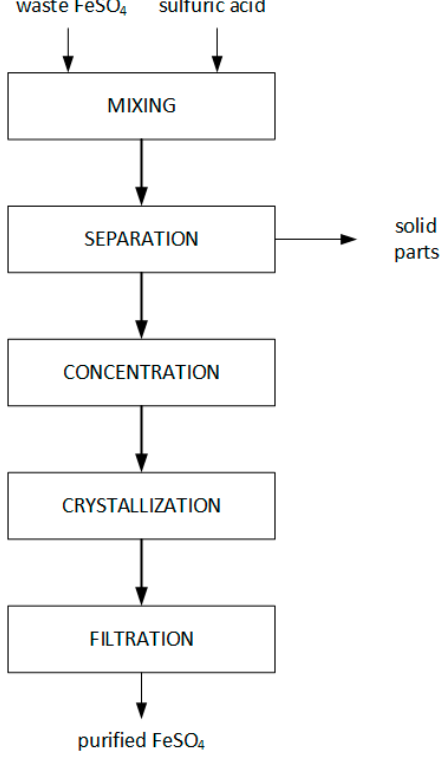
Figure 1. Scheme of the waste FeSO 4 purification process.